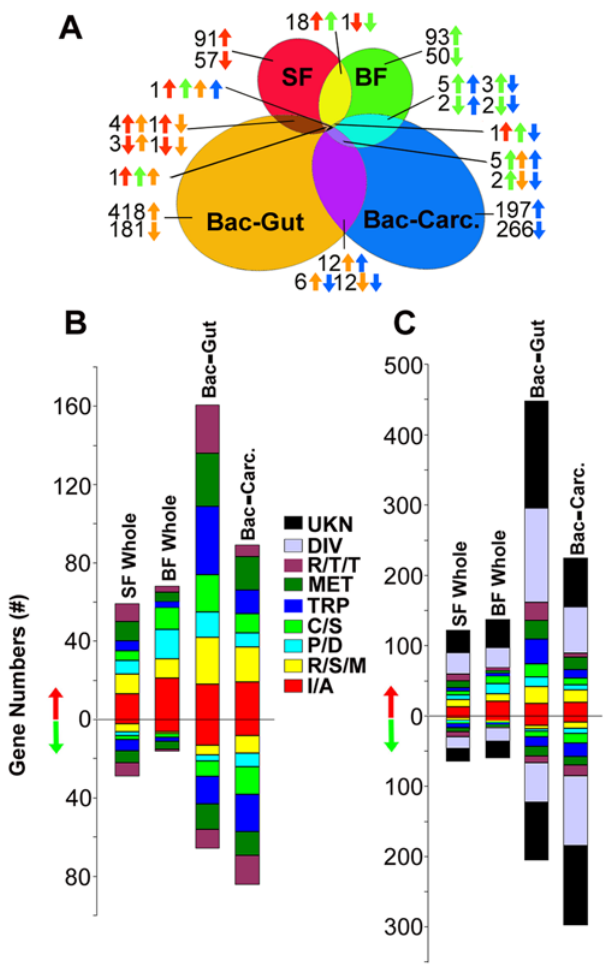
Figure 5. Global gene regulation at the different conditions of infection. (A) Comparison of transcript abundance between whole septic and aseptic mosquitoes after feeding on sugar (SF) or uninfected blood (BF), and in the midguts (Bac-Gut) or carcass tissues (Bac-Carc.) of mosquitoes 12 hrs post ingestion of uninfected blood supplemented with E. coli and S. aureus (substitution of bacteria with PBS as control). Colored arrows indicate genes that are up- or down- regulated in the corresponding treatment group. (B) Proportions and numbers of genes belonging to distinct functional groups which were up- or down- regulated in the corresponding treatment group. SF Whole: sugar-fed whole septic mosquitoes compared to aseptic ones; BF Whole: uninfected blood-fed whole septic mosquitoes compared to aseptic ones; Bac-Gut: mosquitoes midgut tissues 12 hrs post ingestion of experimental bacteria; Bac-Carc.: mosquitoes carcass tissues 12 hrs post ingestion of experimental bacteria ( E. coli and S. aureus ); I/A: putative immunity and apoptosis; R/S/M: oxidoreductive, stress-related and mitochondrial; C/S: cytoskeletal, structural; MET: metabolism; R/T/T: replication, transcription, translation; P/D: proteolysis, digestion; TRP: transport; DIV: diverse; UKN: unknown functions; gene functions were predicted based on Gene Ontology data and manual sequence homology searches. (C) Same as in (B), but also including genes of diverse functions (DIV) and unknown functions